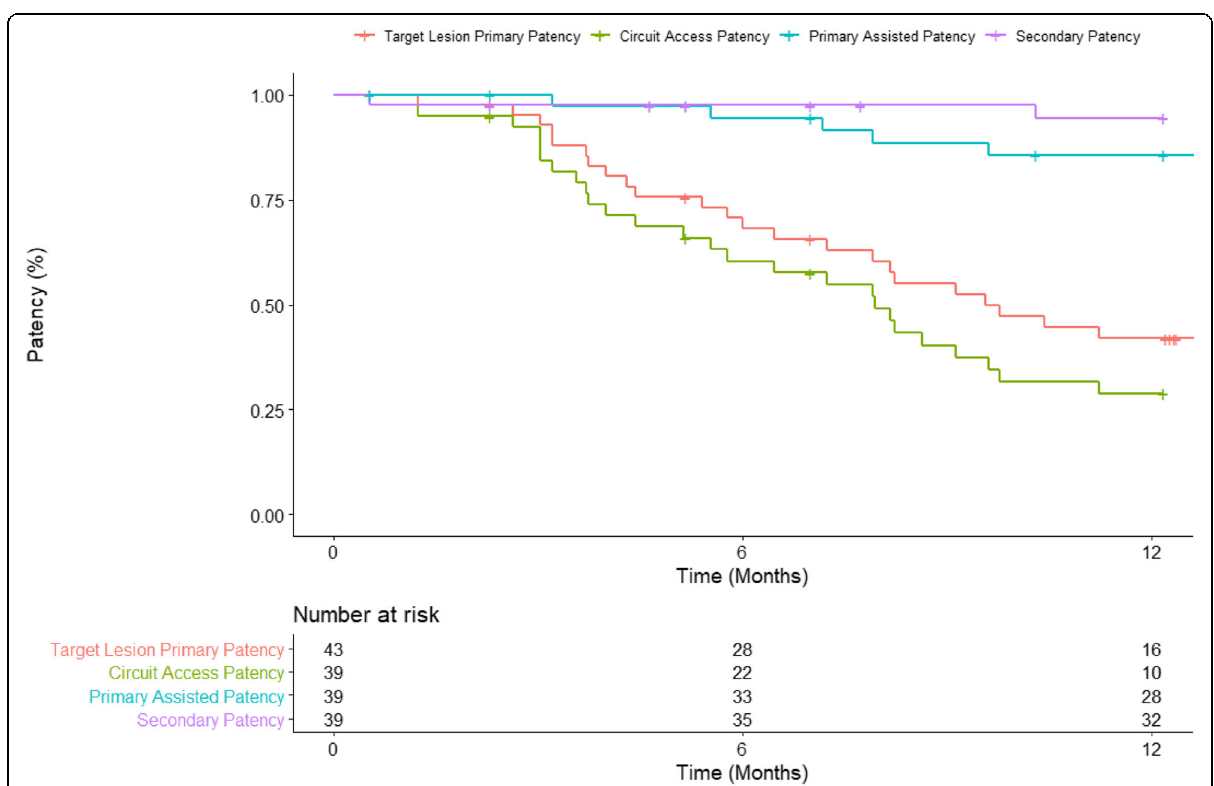
Fig. 1 Kaplan-Meier estimates for target lesion primary patency, circuit access patency, primary assisted patency, and secondary